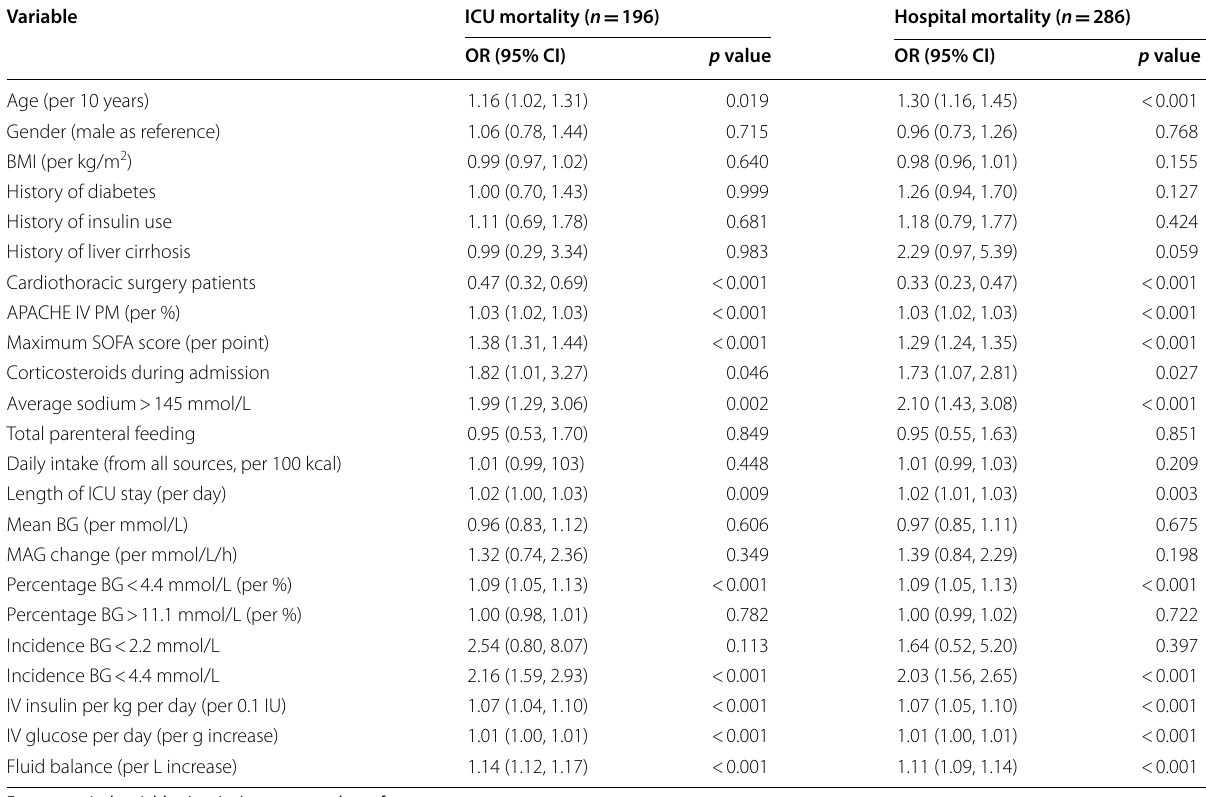
Table 4 Univariate logistic regression analysis for the association with ICU and hospital mortality in the cohort of patients admitted > 72 h ( n =